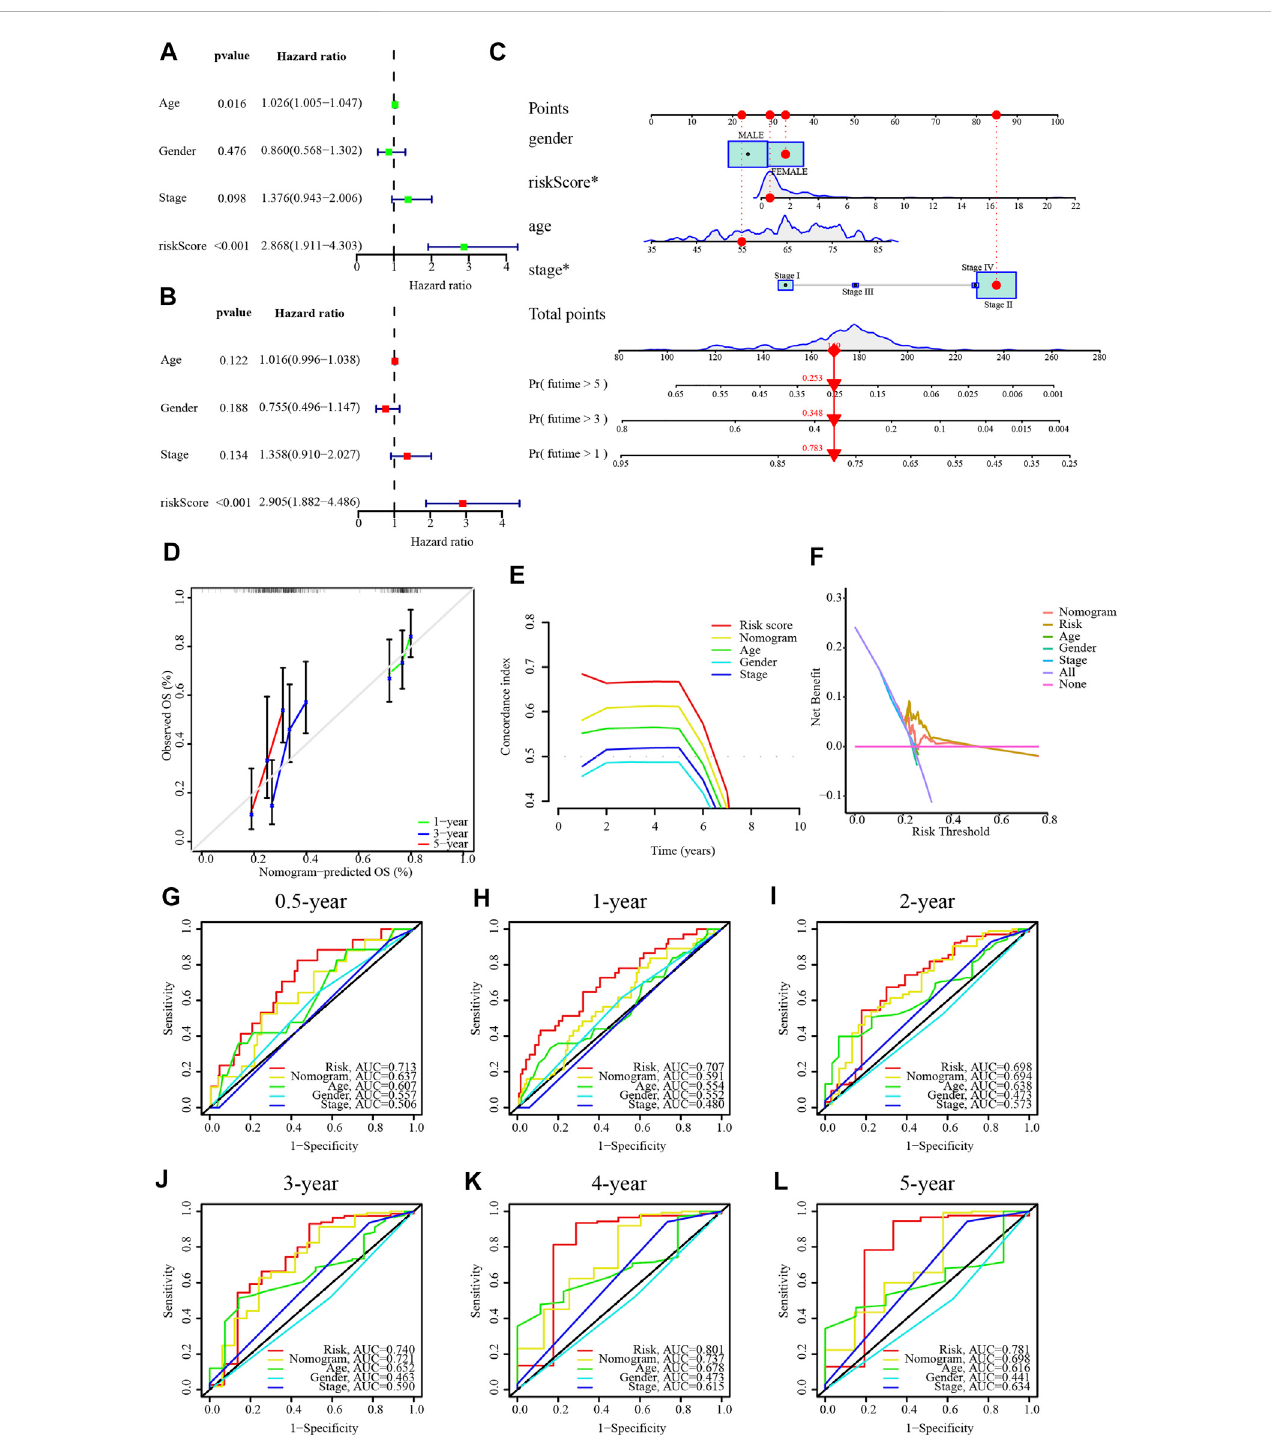
FIGURE 5 AnomogramforPCpatientsinTCGAdataset. (A,B) Independentprognosticvalueofriskscorebyunivariateandmultivariateanalysis. (C) Anomogramof theriskscoreforpredictingthe1-,3-,and5-yearOSofPCpatients. (D) Calibrationcurvesofthisnomogramforthepredictionof1/3/5-yearOSofPCpatients. (E) The concordance index curve of risk score and nomogram. (F) The DCA curve of risk score and nomogram. (G – L) The AUC values for risk score and nomogram predict 0.5/1/2/3/4/5-year OS. * p < .05, ** p < .01; *** p < .001; ns, not signi fi